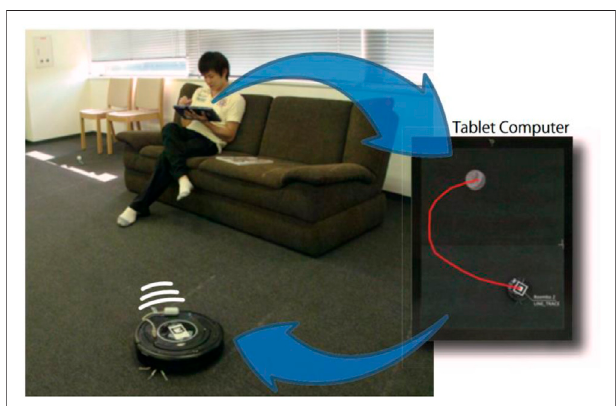
FIGURE 3 | A sketch-based control interface for a robot that overlays commands in an overhead view of the real world to aid control and understandability of the robot ’ s future actions. From Sakamoto et al. (2009), with permission .